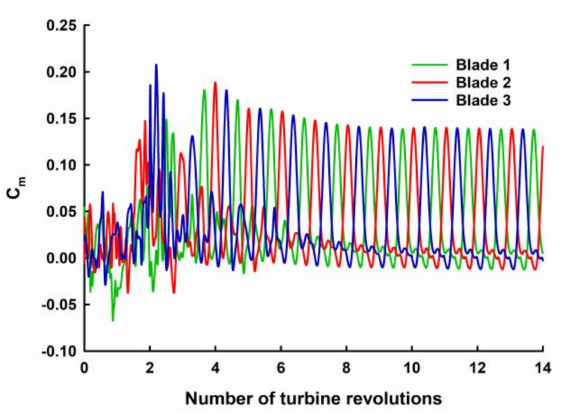
Figure 5. Cyclic convergence of solution for a 60 ◦ helical blade VAWT running at λ = 2.3.